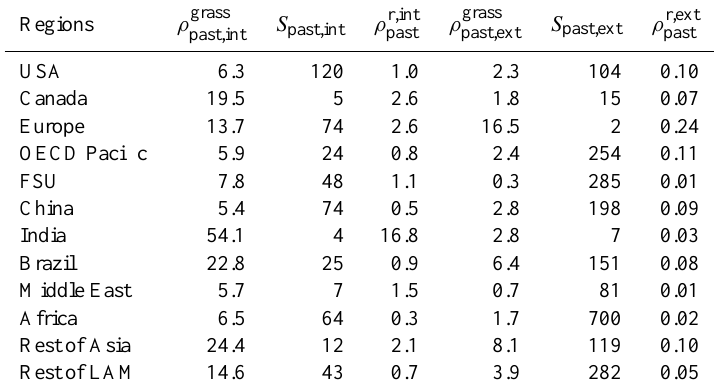
in Mkcalha − 1 yr − 1 , intensive permanent pasture area S past,int past,int